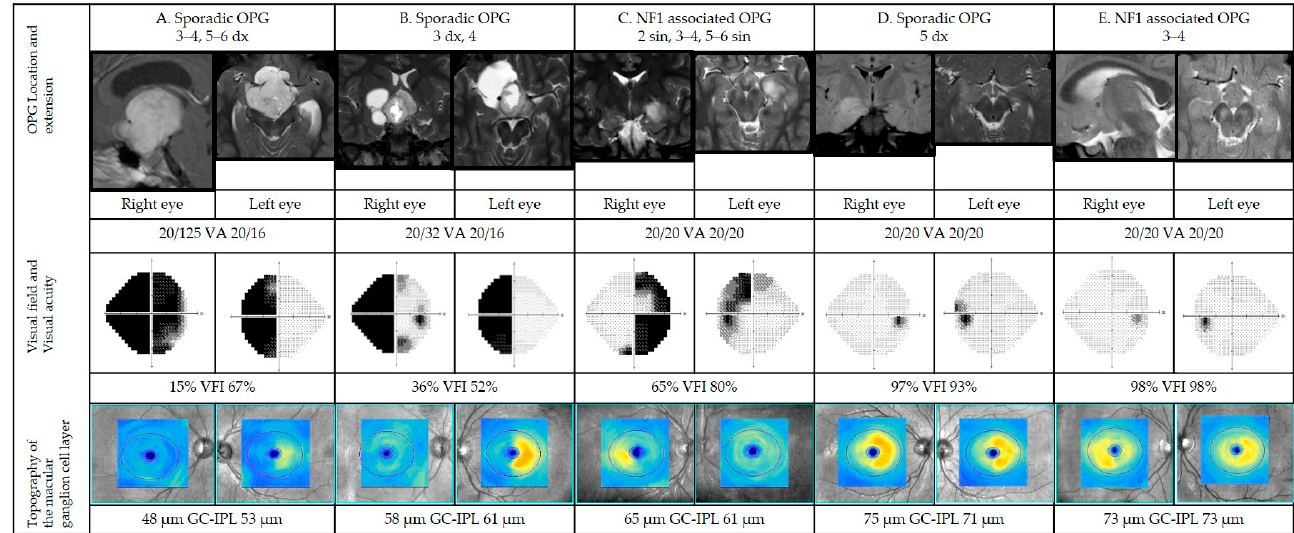
Figure 6. Representative cases of patients with optic pathway gliomas (OPGs) in different anatomic locations (please see Figure 1; dx: right side, sin: left side). Magnetic resonance imaging (MRI), visual acuities, visual fields, and optical coherence tomographies for cases A – E . For each case, OPG is presented on representative MRI. Visual fields are presented in gray scale, black indicating visual field defects. Sensitivity as percentage of the intact visual field (visual field index). Below, color-coded topography of the macular ganglion cell ‐ internal plexiform layer (GC ‐ IPL), blue color indicating thinning. Average GC ‐ IPL values for each eye in microns. GC ‐ IPL—ganglion cell ‐ internal plexiform layer; VA—visual acuity; VFI—visual field index. Dx—right; sin—left.